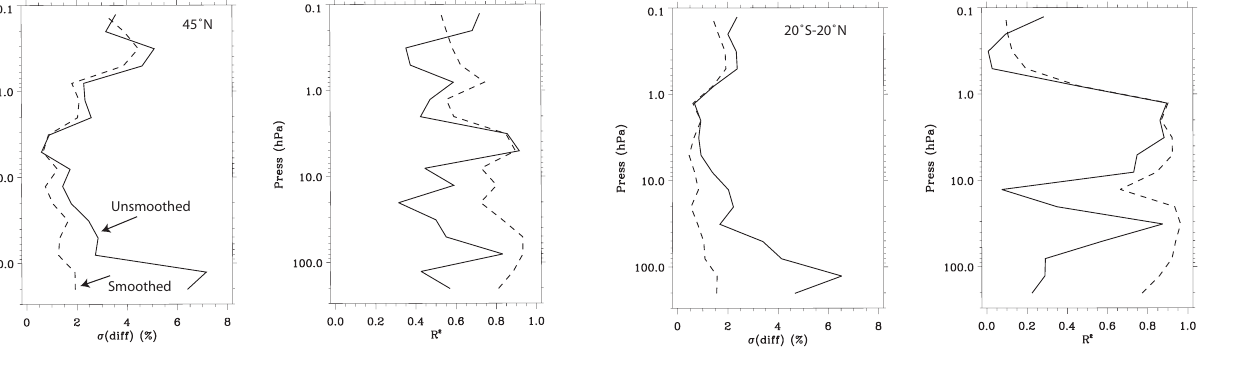
Fig. 18. Same as in Fig. 11 but for tropics (20 ◦ S–20 ◦ N). Smoothing has larger effect than at 45 ◦ N since the layer DFS is smaller in the tropics. Poor correlation in the mesosphere, even with smoothing, is probably due to diurnal effects. Poor correlation at 16hPa is caused by distortion of the phase of the QBO by SBUV due to vertical smoothing.